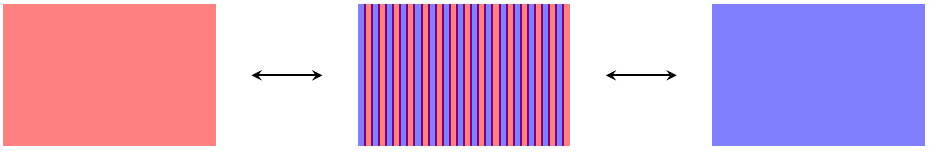
Figure 5 . A mesoscopic lattice of invertible interfaces between two systems realizes a continuous interpolation between